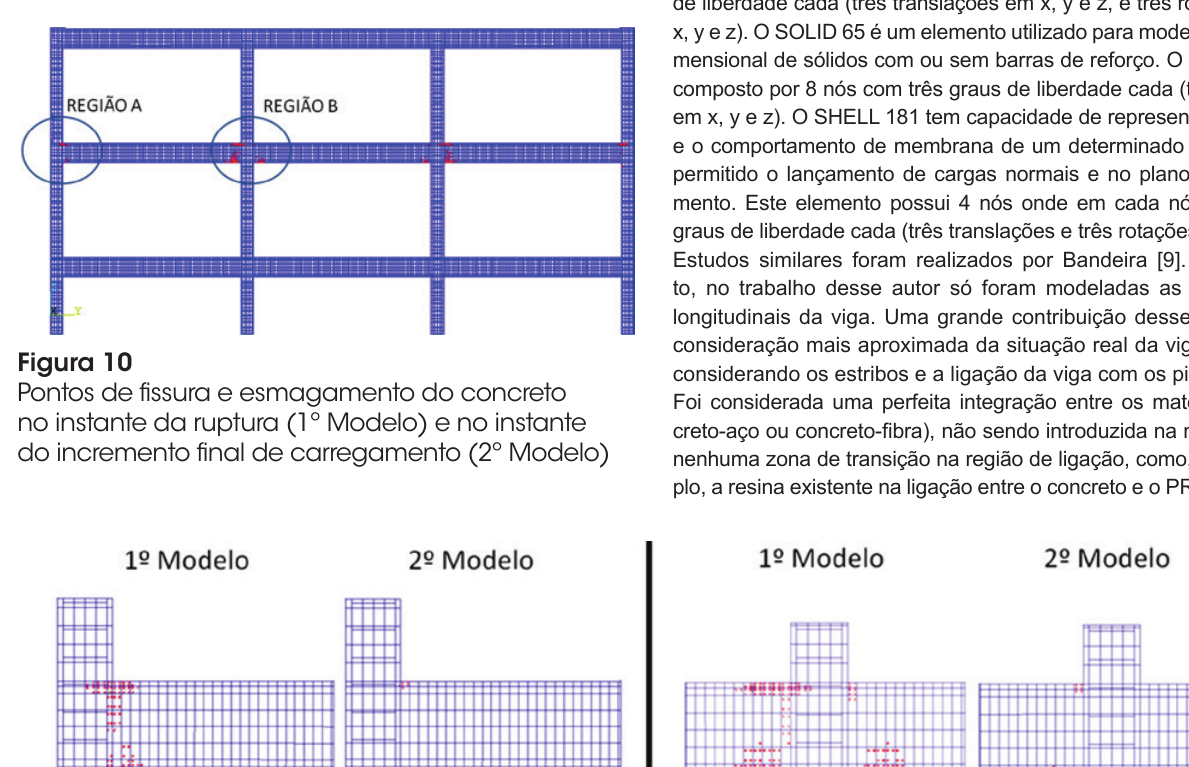
Vista dos elementos modelados na ligação viga-pilar